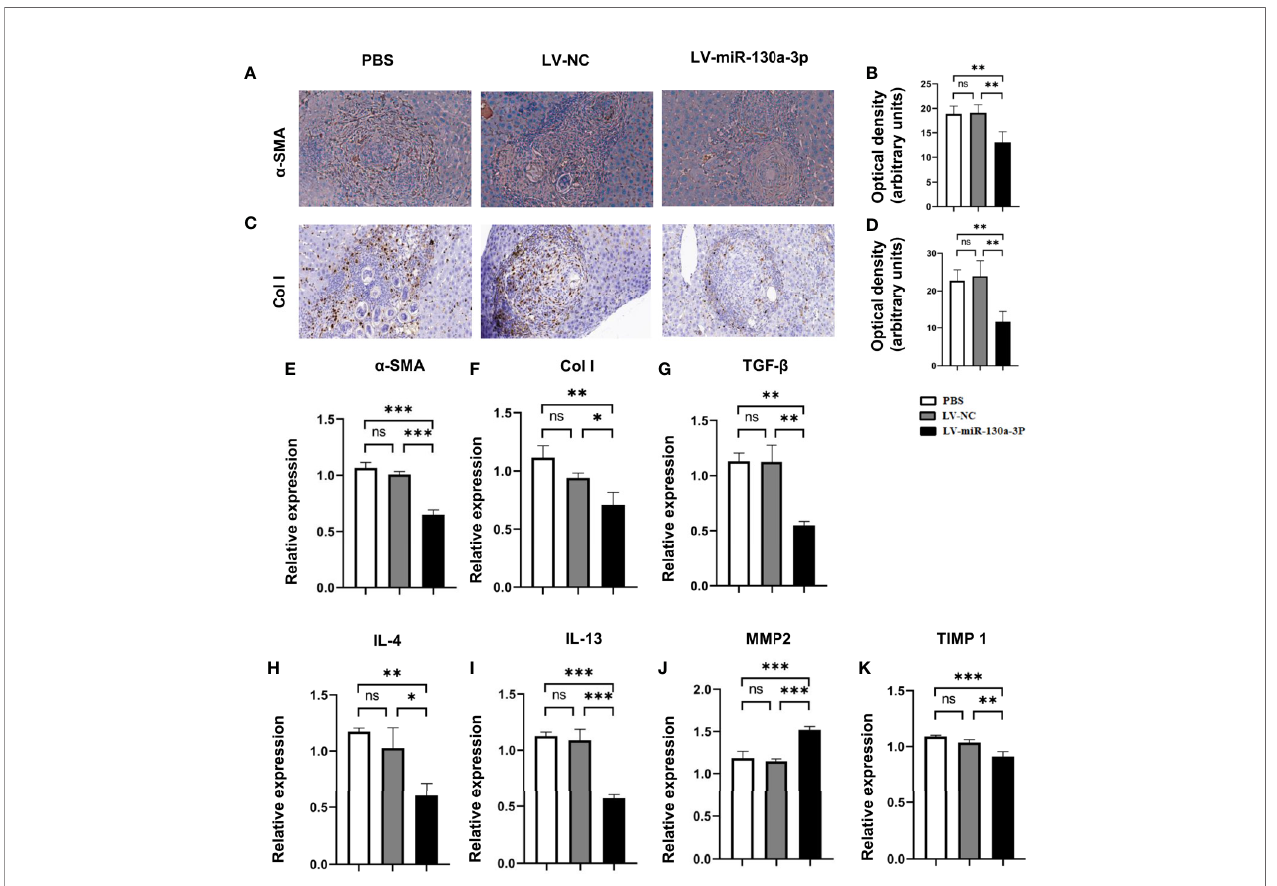
FIGURE 3 | LV-miR-130a-3p decreased the levels of Col I by reduced expression of proin fl ammatory factor. The a -SMA protein level in the liver was evaluated by IHC with quantitative analysis of optical density (A, B) . The Col I protein level in the liver was evaluated by IHC with quantitative analysis of optical density (C, D) . Liver RNA was extracted and the expressions of a -SMA and Col I were analyzed by qRT-PCR (E, F) . Liver RNA was extracted and the expressions of proin fl ammatory factor, TGF- b , IL-4, IL-13, MMP2, and TIMP1were analyzed by qRT-PCR (G – K) . Data represent mean±SD from multigroup experiments. * p < 0.05, ** p <0.01 and *** p <0.001 (n=4 each group). ns, no signi fi